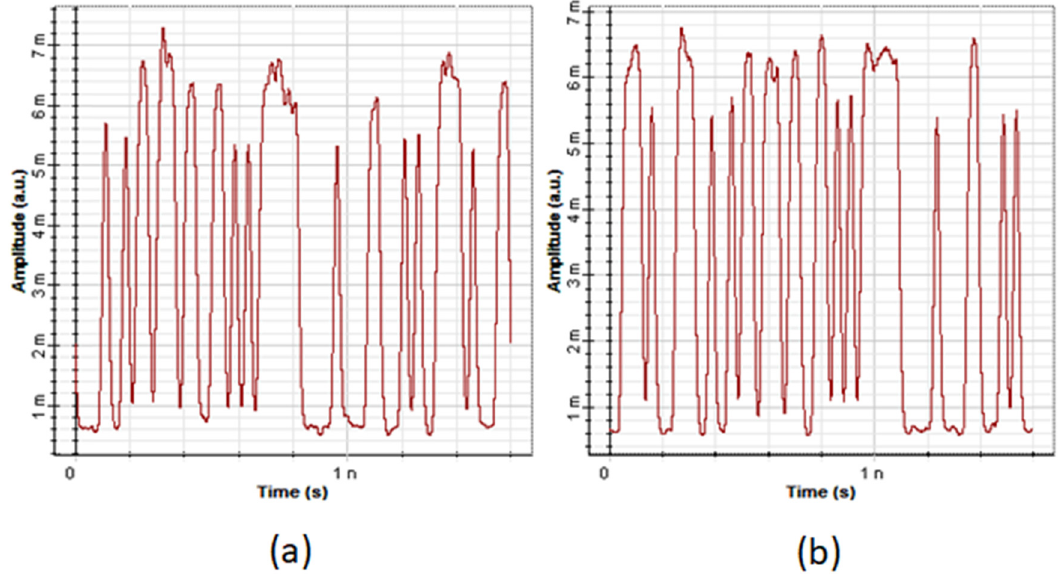
Figure 5: Amplitude vs time directly after photodetector ( PIN ) at the side receiver for add: ( a ) signal_1 = 193.1 THz and ( b ) signal_4 = 193.4 THz @span = 200 km, and bitrate = 40 ( 3 ) In Figure 6, from the oscilloscope visualizer, the comparison of amplitude vs time is shown as drop channel_1 ( 193.1 THz ) to channel_4 ( 193.4 THz ) after 200 km of fi ber optic transmission link of Solitons type directly after photodiode and fi lter at the receiver side, which have a good quality in the fi gure.